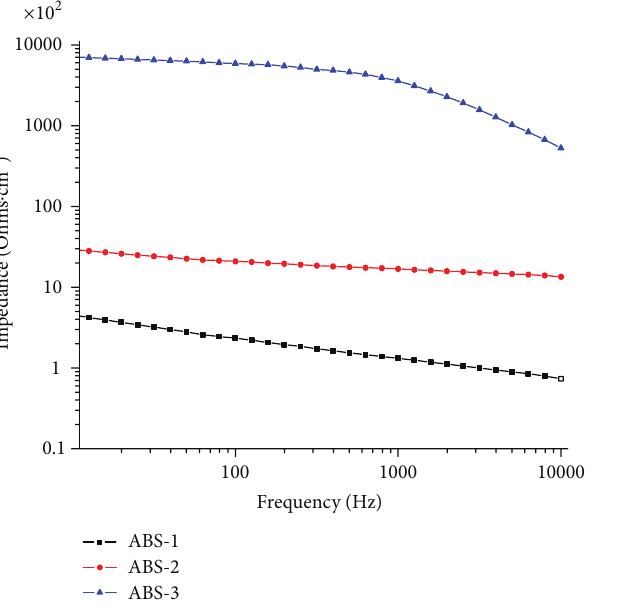
Figure 6: Bode impedance diagrams of ABS-3 copper coated in Na 2 SO 4 + 3wt% NaCl solution.